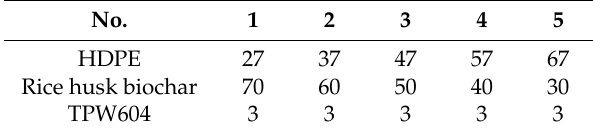
Table 1. The content of different ingredients in the formula (wt %).